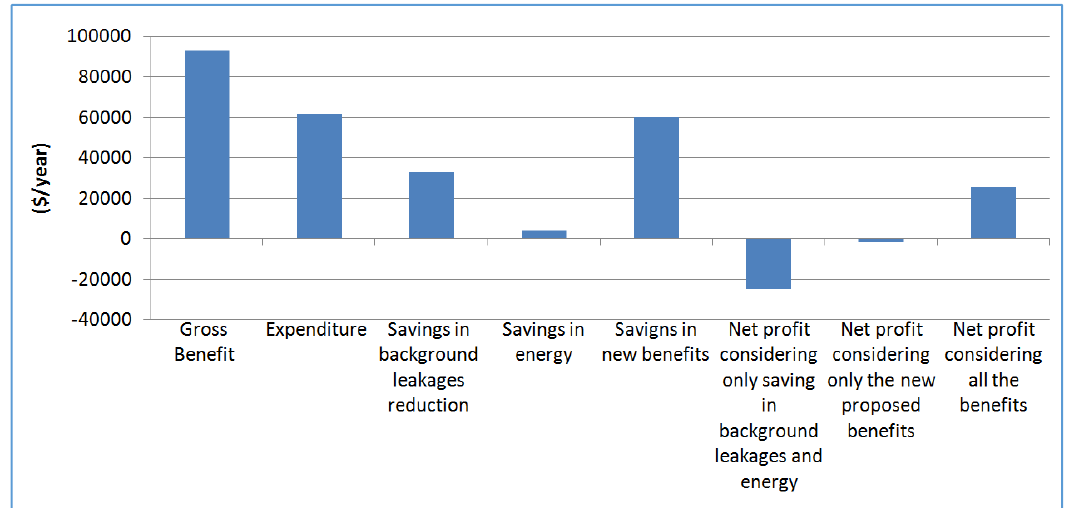
Figure 13. Comparison among the annual benefits and annual expenditures.